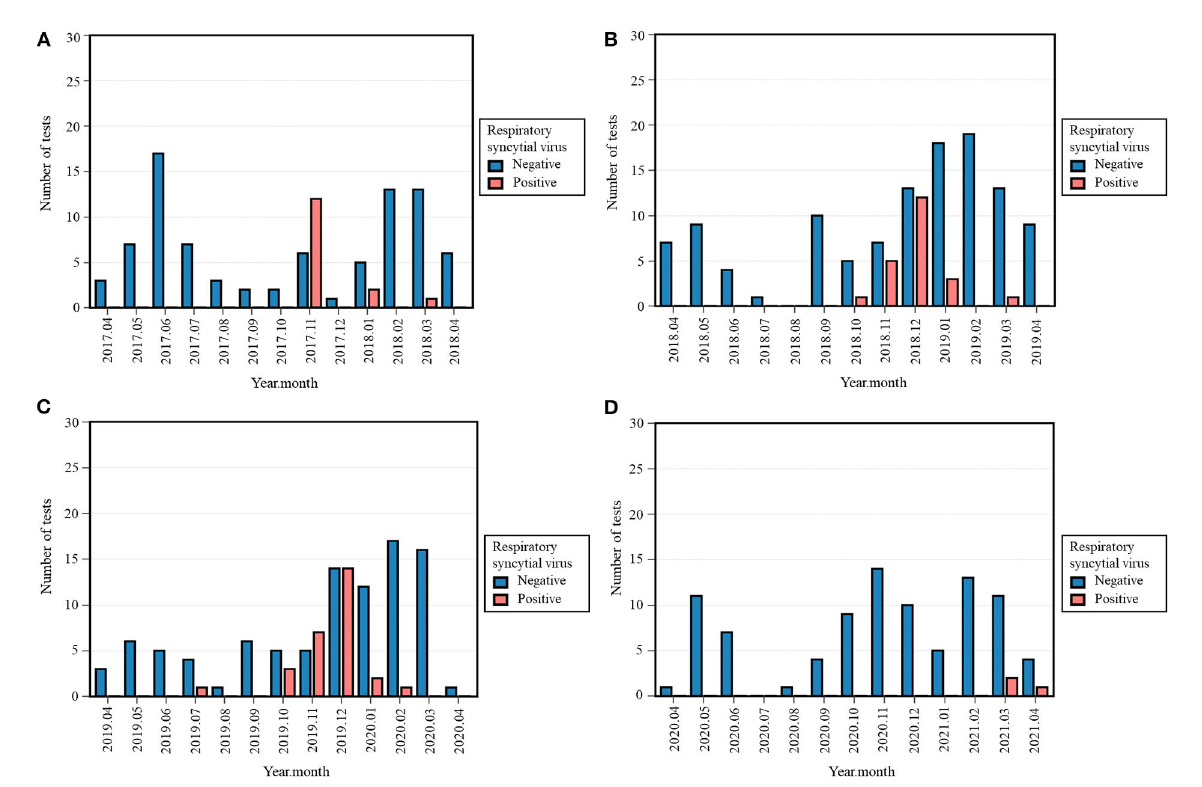
FIGURE3 Monthly occurrence of respiratory syncytial virus (RSV) per year: 2017-2018 (A) , 2018-2019 (B) , 2019-2020 (C) , 2020-2021 (D) . Monthly occurrence was defined as the number of positive tests per month. Each 12-month period started on April 16th and ended on April 15th of the following year.